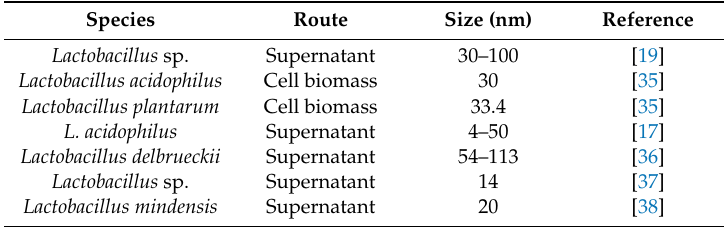
Table 1. Lactobacillus mediated synthesis of silver